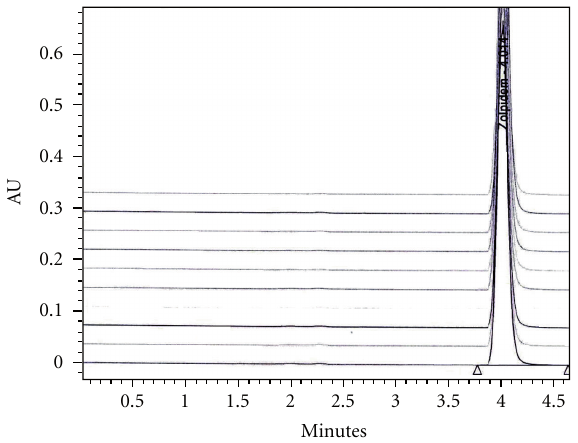
F 2: Chromatograms of a solution containing zolpidem at a concentration of 20